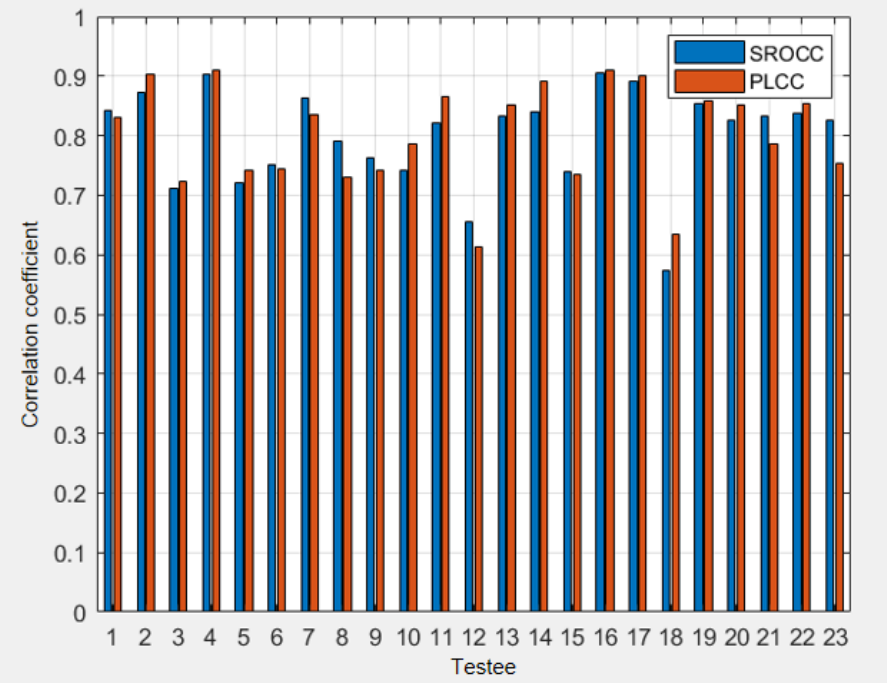
Figure 8. The correlations between each subject and the